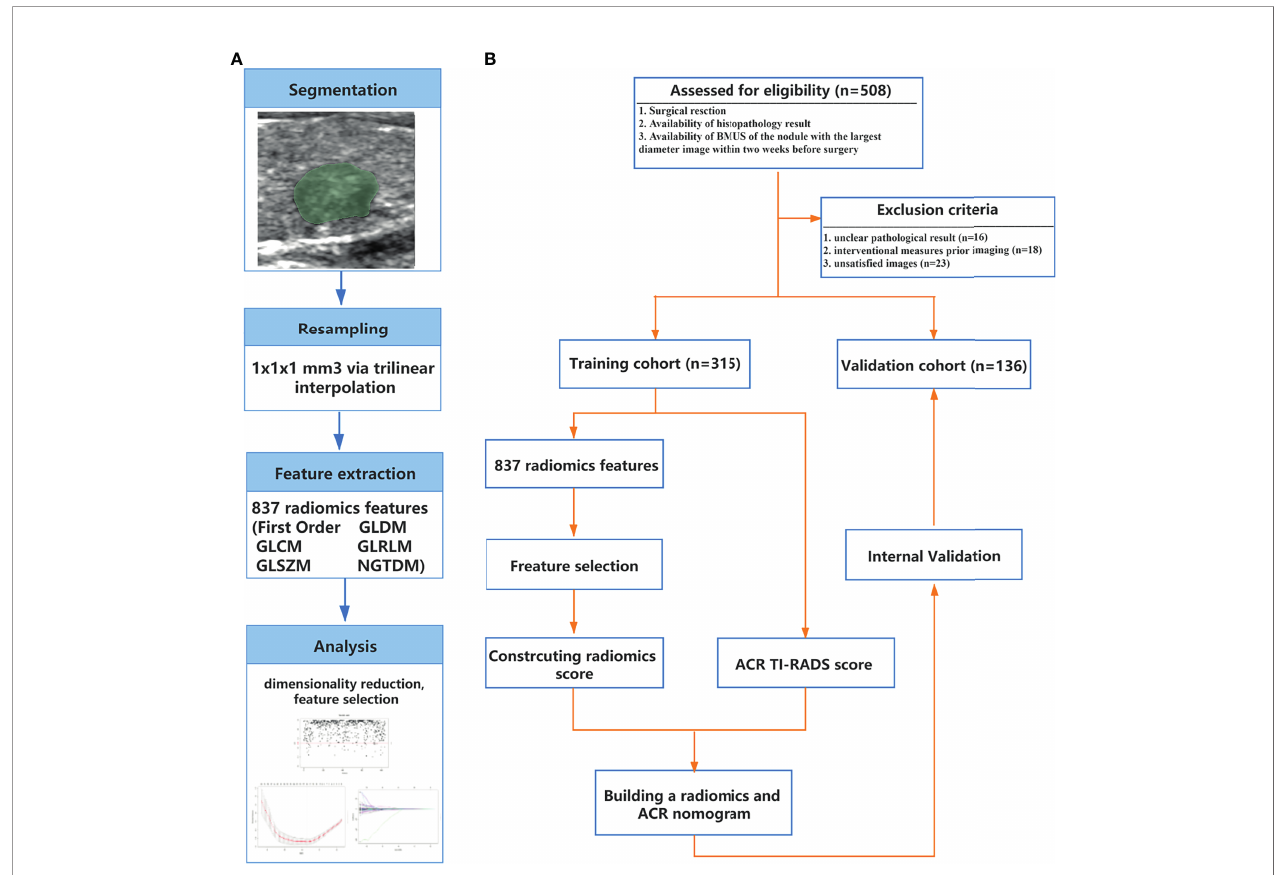
FIGURE 1 | B-model ultrasound radiomics work fl ow (A) and study fl owchart (B) . ACR, American College of Radiology; BMUS, B-model ultrasound; GLCM, gray- level co-occurrence matrix; GLDM, gray-level dependence matrix; GLRLM, gray-level run length matrix; GLSZM, gray-level size zone matrix; NGTDM, neighboring gray tone difference matrix; TI-RADS, thyroid imaging reporting and data